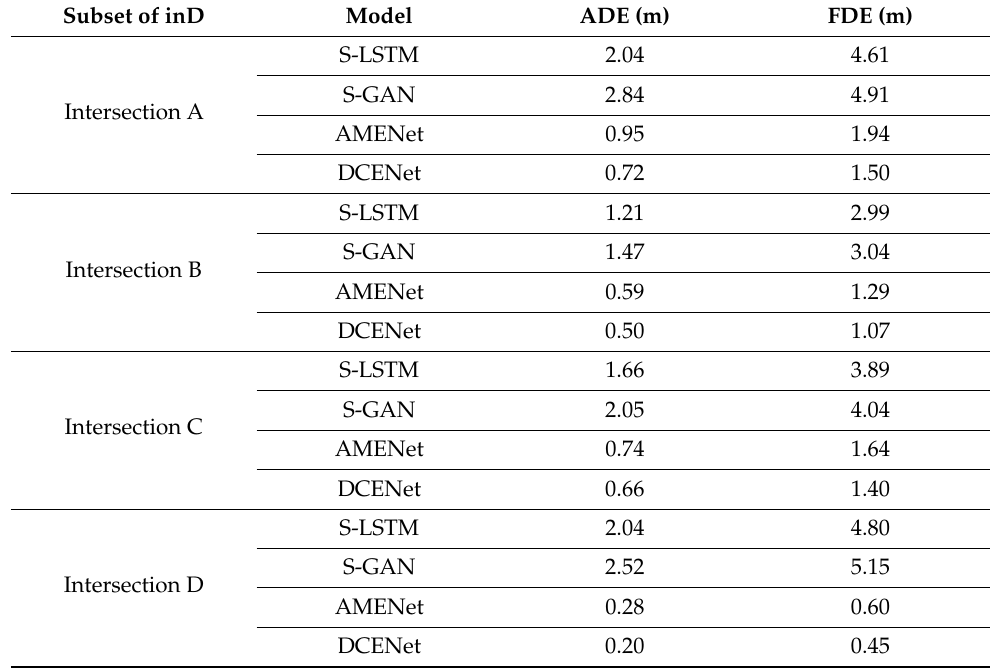
Table 7. Performance of vehicle trajectory prediction models on the inD dataset reported in [23]. Subset of inD